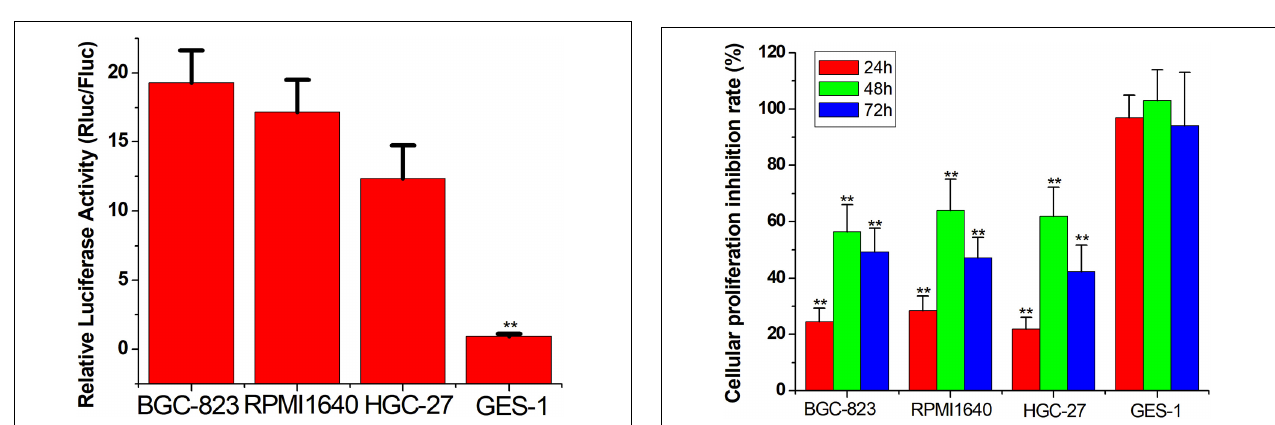
FIGURE 3 | Distinguishing between gastric cancer cells and normal cells. Cell luciferase activity was determined using the dual luciferase reporting assay (** p < 0.01). Data were expressed as mean ± SD.